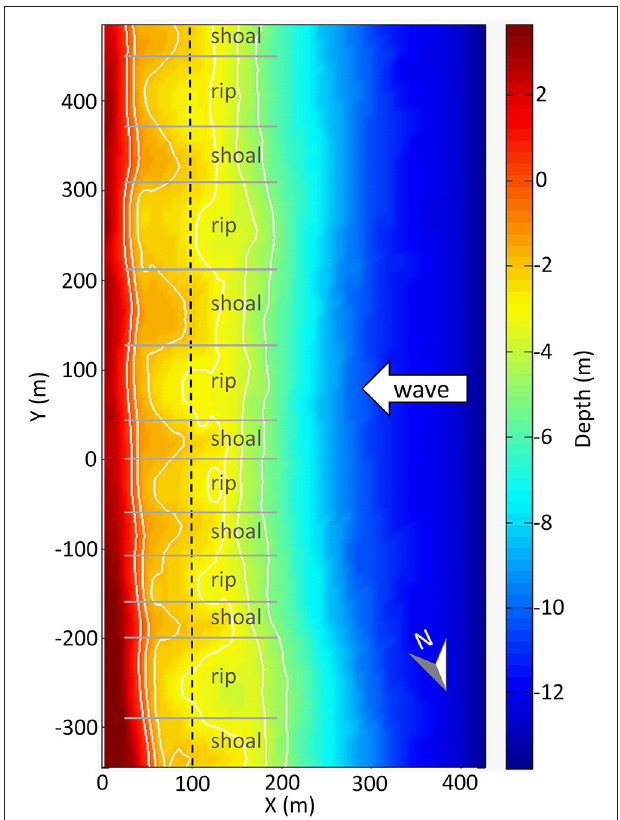
FIGURE 3 | Bathymetry at Sand City beach. White isobaths are in 1m increments from depth of 0m (shoreline) to 5m. Black dashed line at 100m approximates the surf zone edge (breaker line). The modeled wave angle obtained from time-averaged field data are indicated by the large arrow. Ranges of rip channels and shoals are